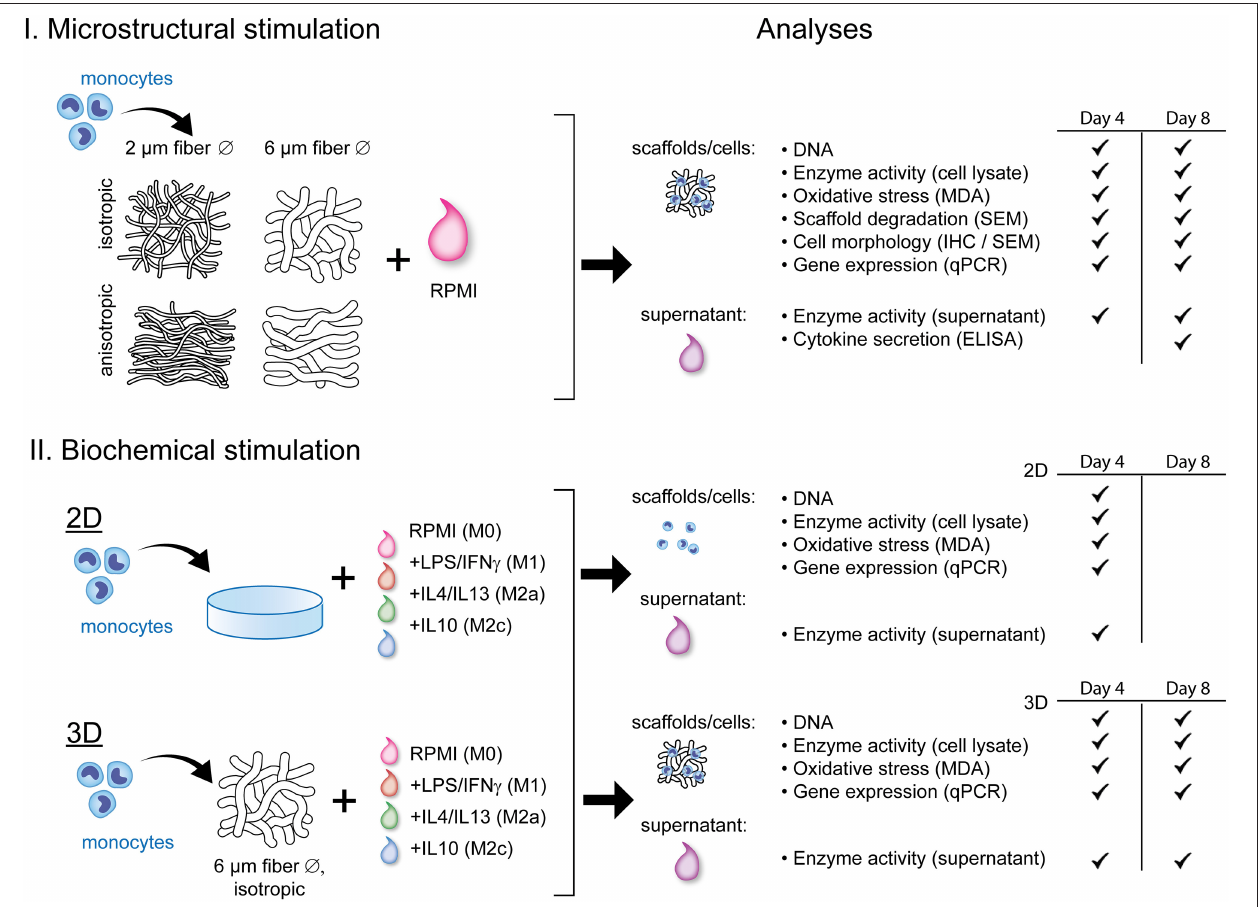
FIGURE 1 | Schematic representation of the experimental outline and analyses. THP-1 derived macrophages were exposed to either scaffold microstructural stimuli (I) or biochemical stimuli (II) and analyzed for their degradation profile and phenotype. RPMI, Roswell Park Memorial Institute; 1640 medium; LPS, lipopolysaccharide; IFN- γ , interferon gamma; IL, interleukin; MDA, malondialdehyde; SEM, scanning electron microscopy; IHC, immunohistochemistry; ELISA, enzyme-linked immunosorbent assay; qPCR, quantitative polymerase chain reaction.